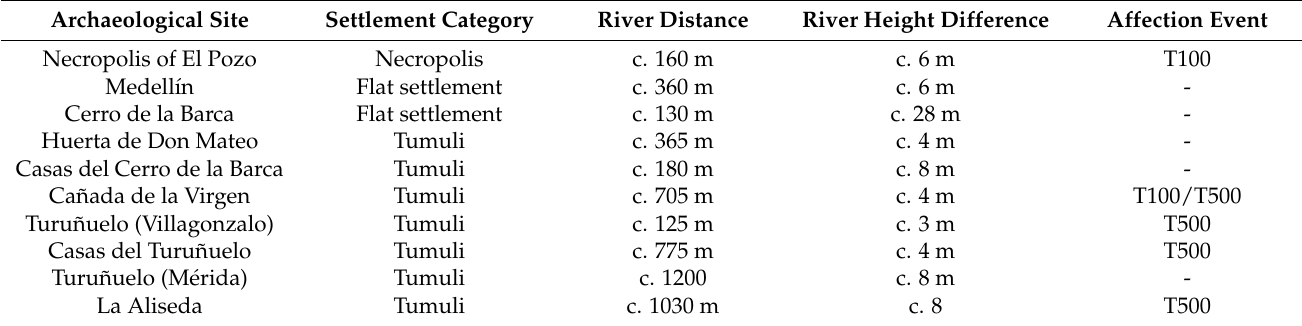
Table 1. List of sites analysed with respect to the nearest watercourse, their height and the flood events that affect them. Archaeological Site